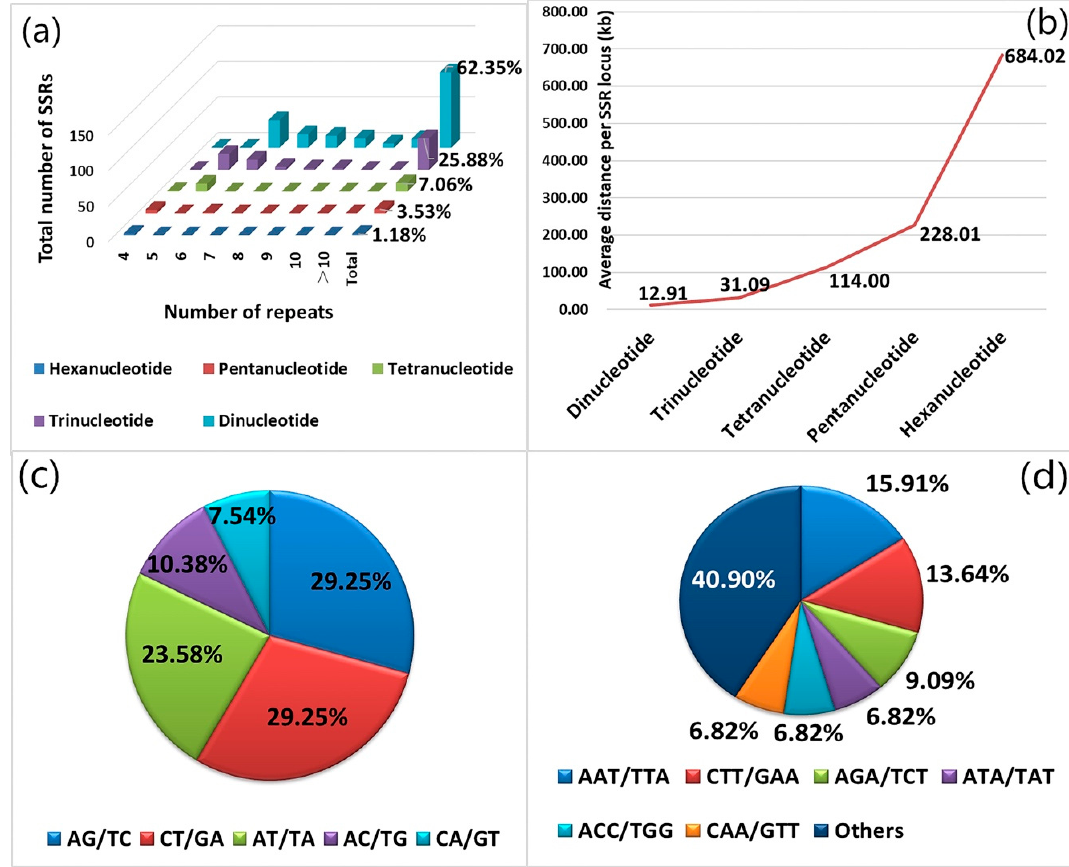
Figure 1. Total number, frequency, and distinct motif repeat types of simple sequence repeats (SSRs) in black locust expressed sequence tag (EST) sequences. ( a ) Motif number distributions of dinucleotide to hexa-nucleotide motif types with different numbers of repeats in black locust EST sequences. ( b ) Average distance per SSR locus among the dinucleotide to hexa-nucleotide motif types. Frequencies of the motifs in ( c ) dinucleotide and ( d ) tri-nucleotide repeats.